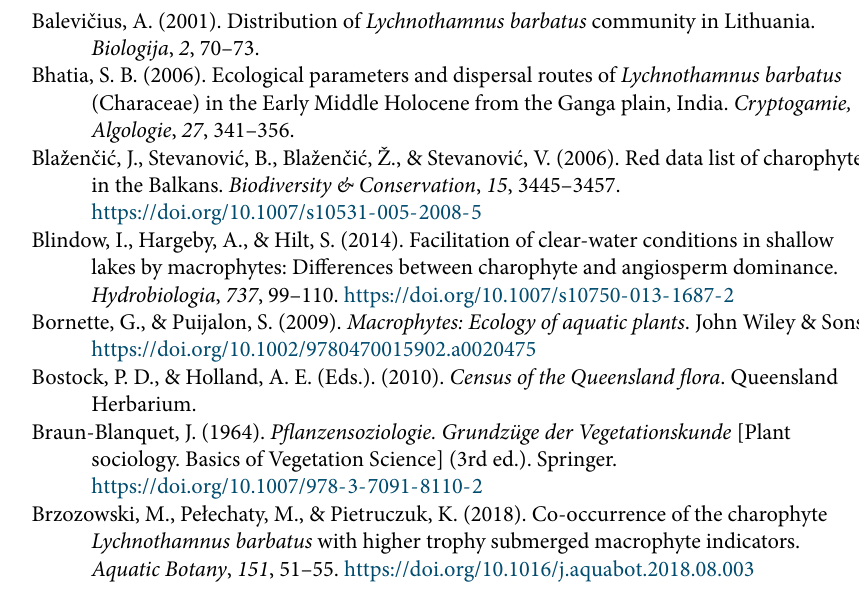
Table S2. Lakes with the most abundant populations of Lychnothamnus barbatus